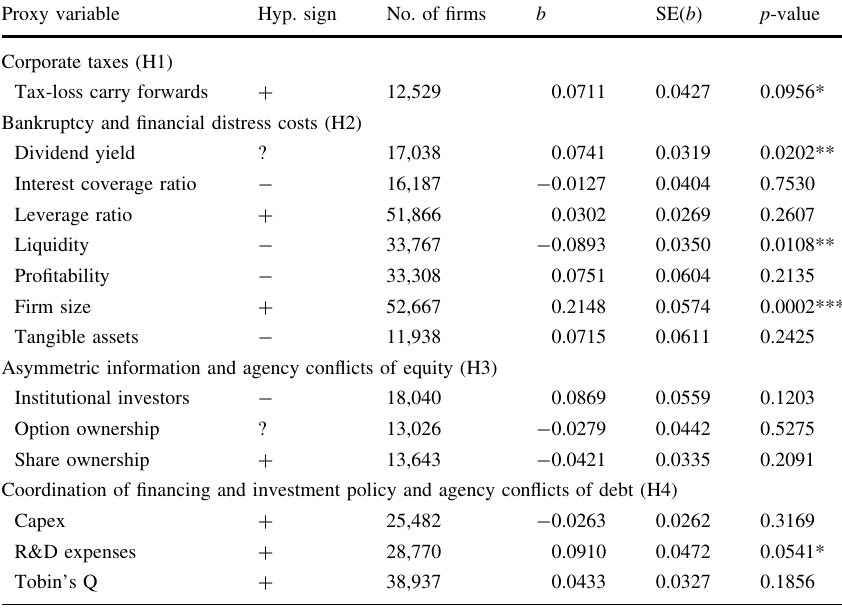
Table 4 Statistical results from multivariate meta-analysis Proxy